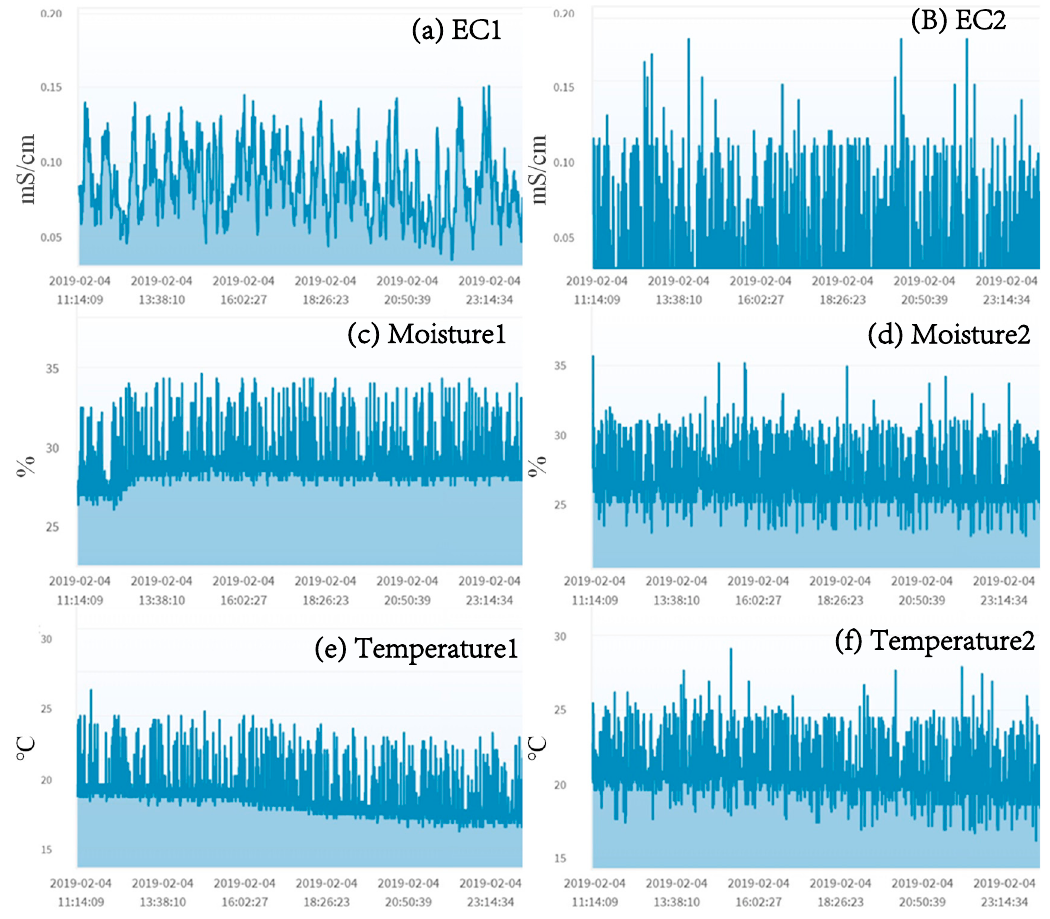
Figure 7. The soil sensors in nearby locations of the Longtan